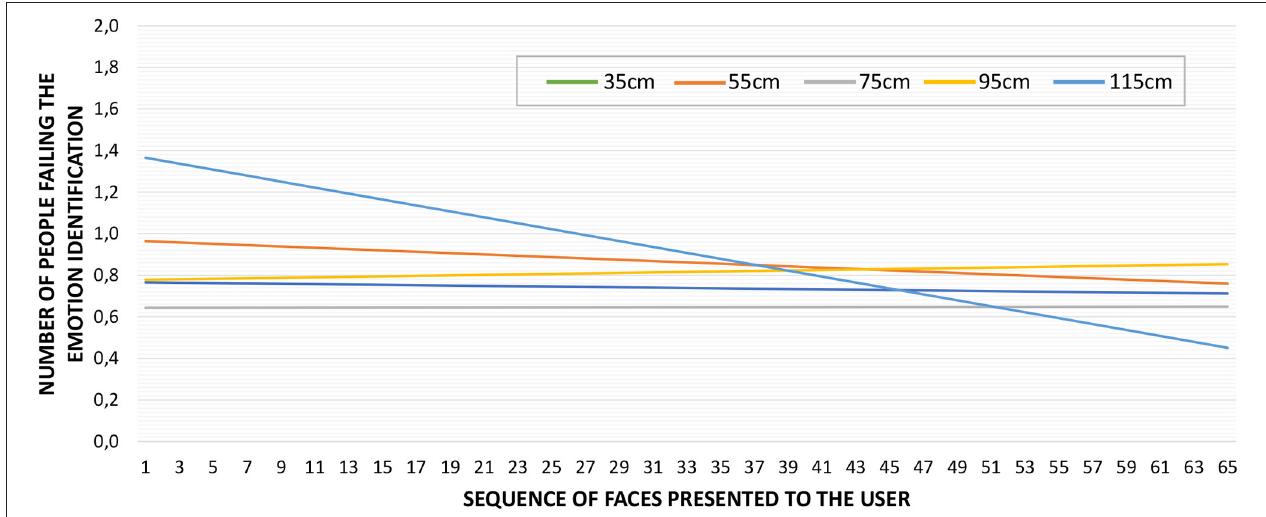
FIGURE 9 | Average reaction time for each face presented to the users. Only trend lines are displayed for